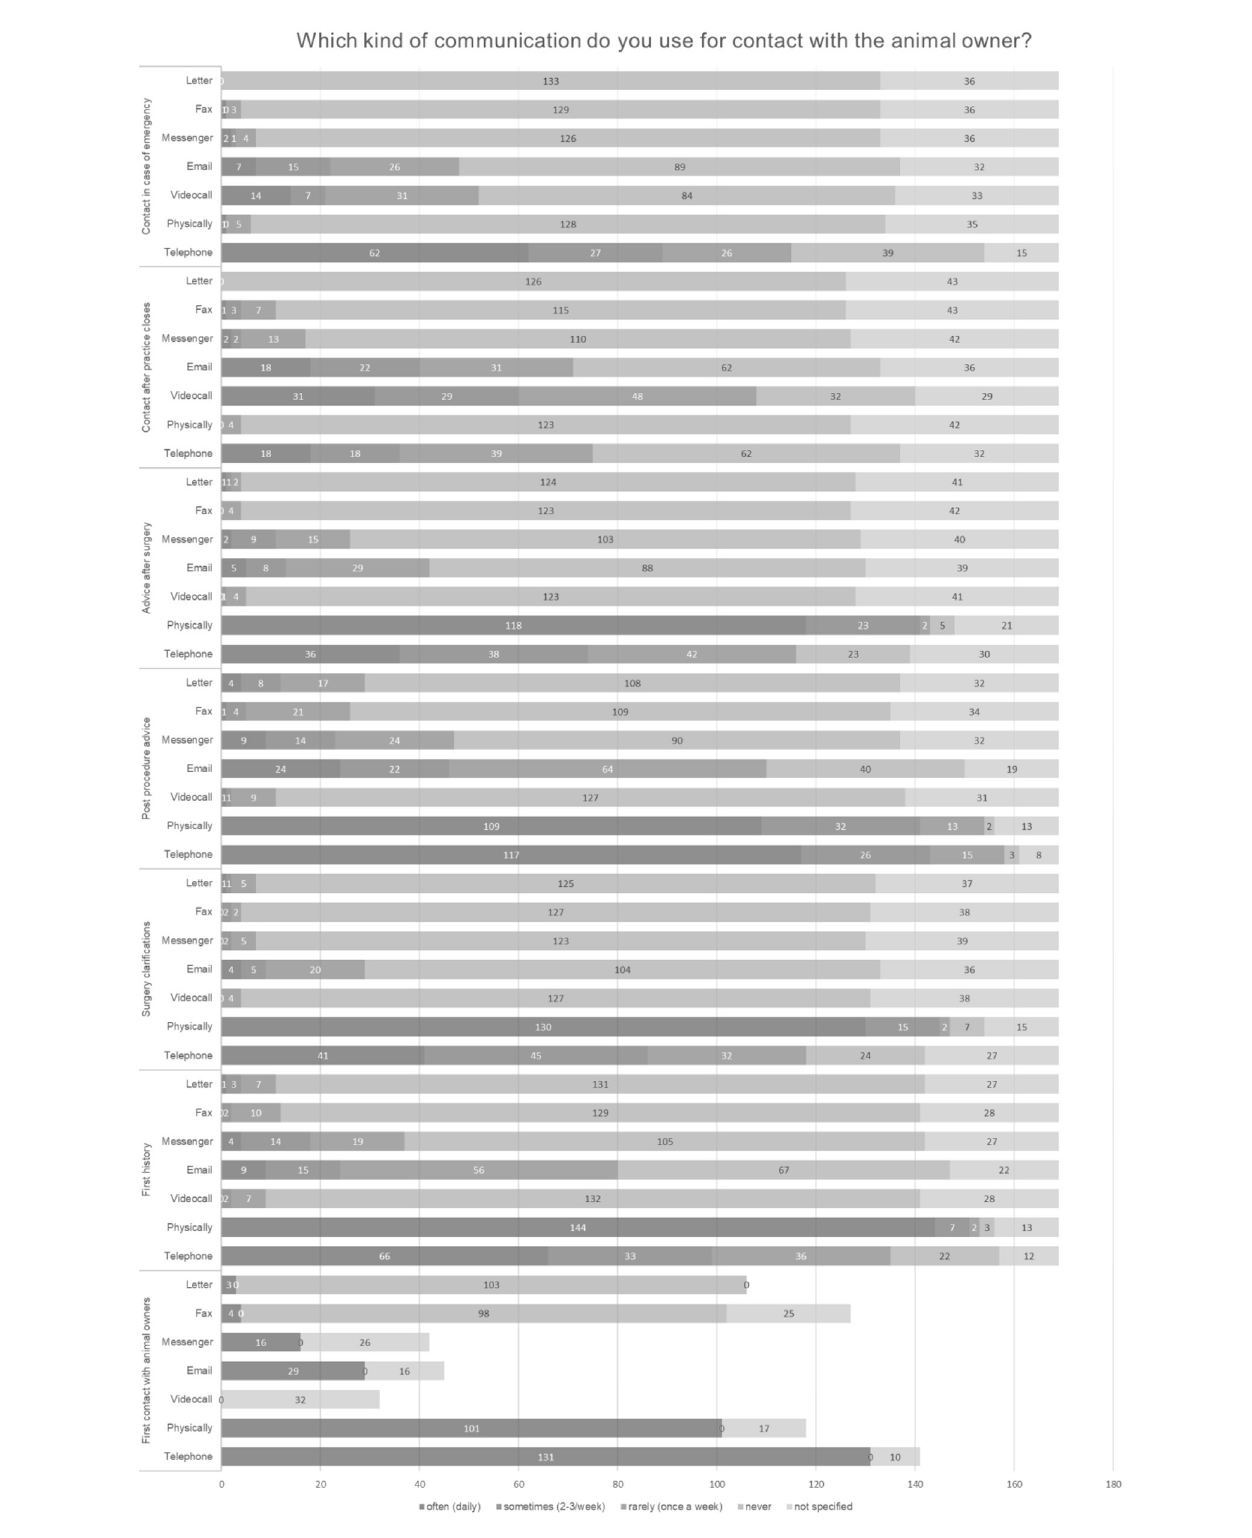
FIGURE5 Kind of communication with the owner ( N = 169).